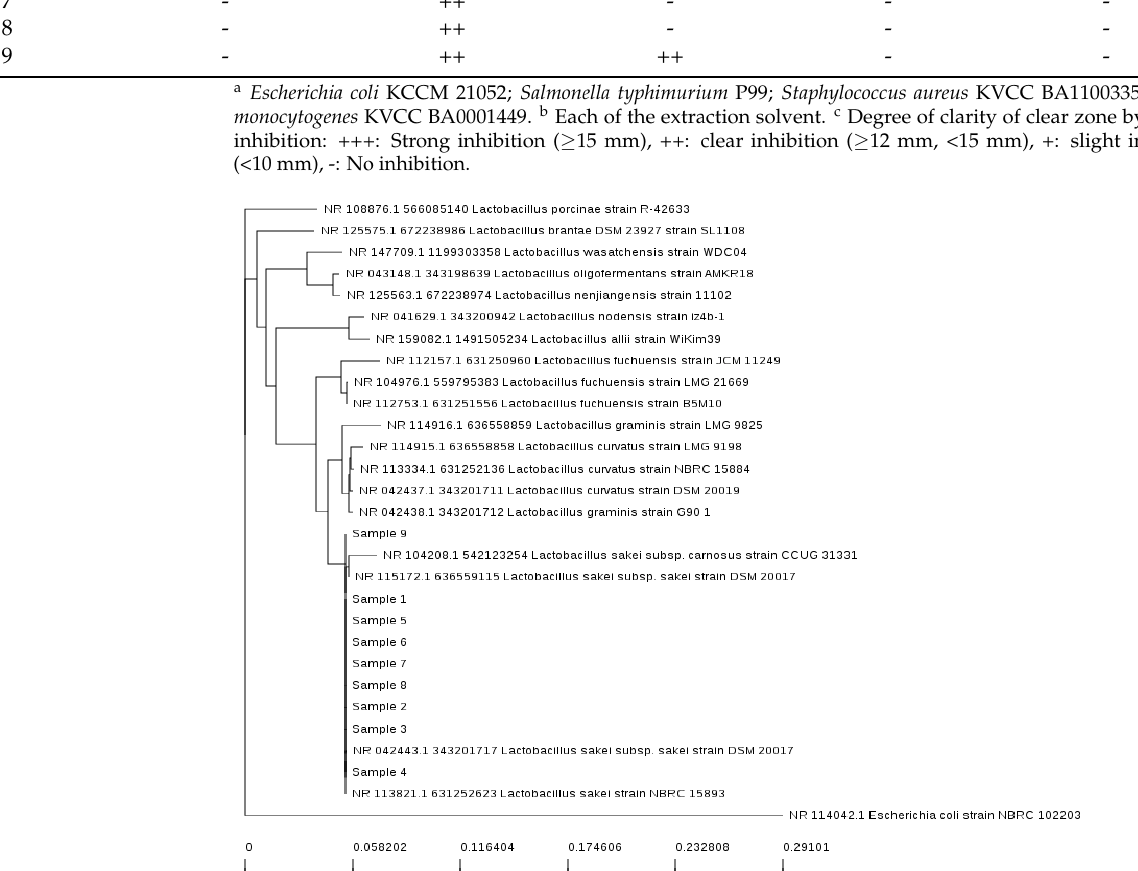
Figure 2. Phylogenetic tree construction using the neighbor-joining method and gene sequences, based upon 16S rRNA sequencing. The figure shows the positions of strains and other closely related lactic acid bacteria (LAB) isolated from long-term fermented Godulbaegi kimchi (LGK).